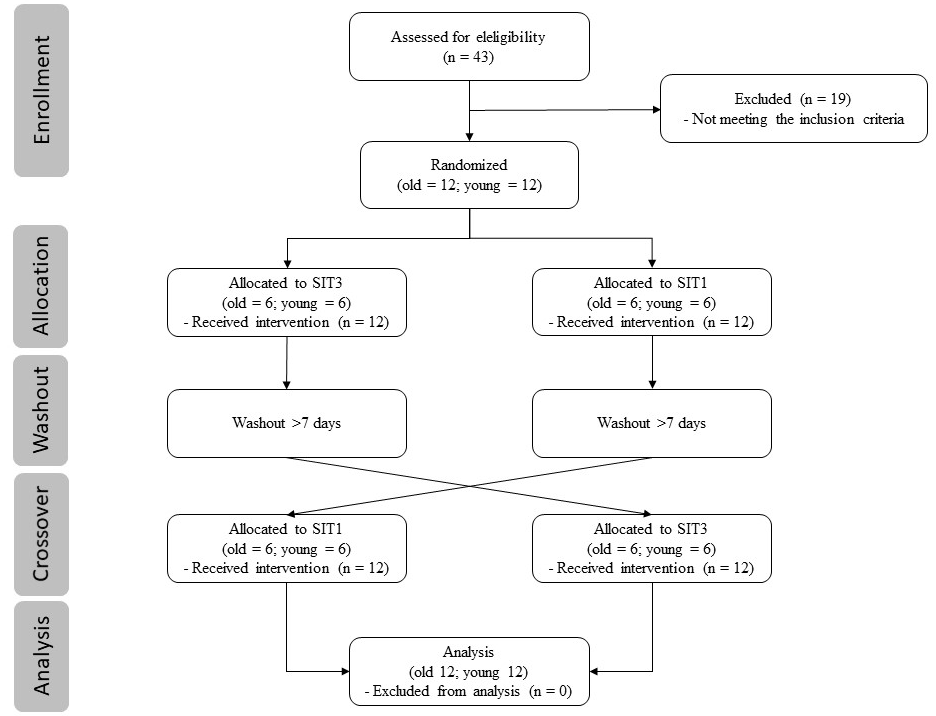
Figure 1. Flow diagram.